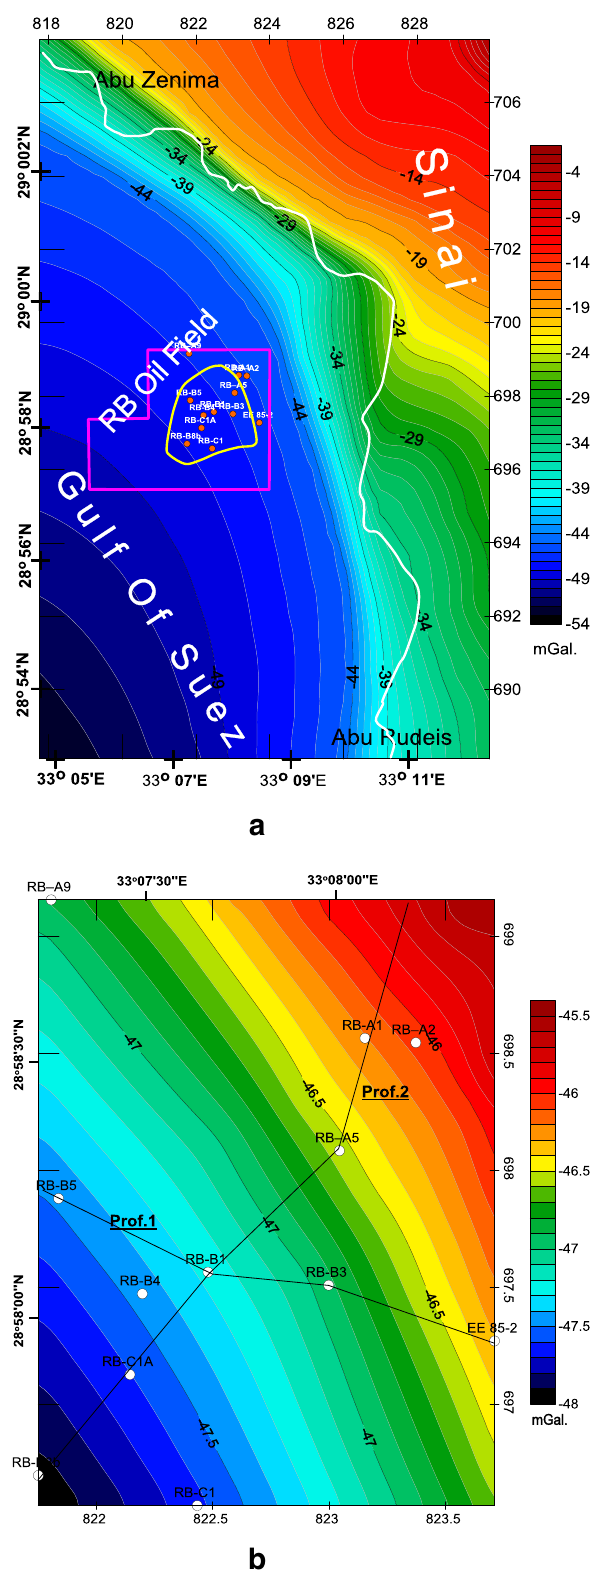
Fig. 3 a Bouguer gravity anomaly map of the study area. b Bouguer grav- ity anomaly map of Ras Budran oil field showing locations of the drilled wells and modeled